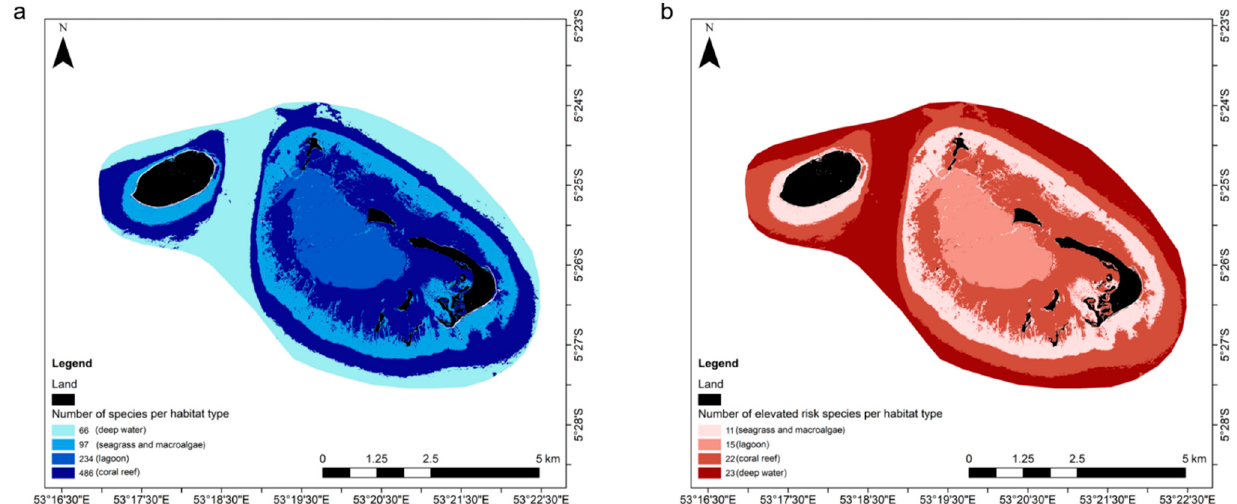
Figure 4. Species richness map of D’Arros and St Joseph for ( a ) all species and ( b ) ER species, with major marine habitat types displayed. Lighter to darker colour represents increasing number of species using the habitat type.